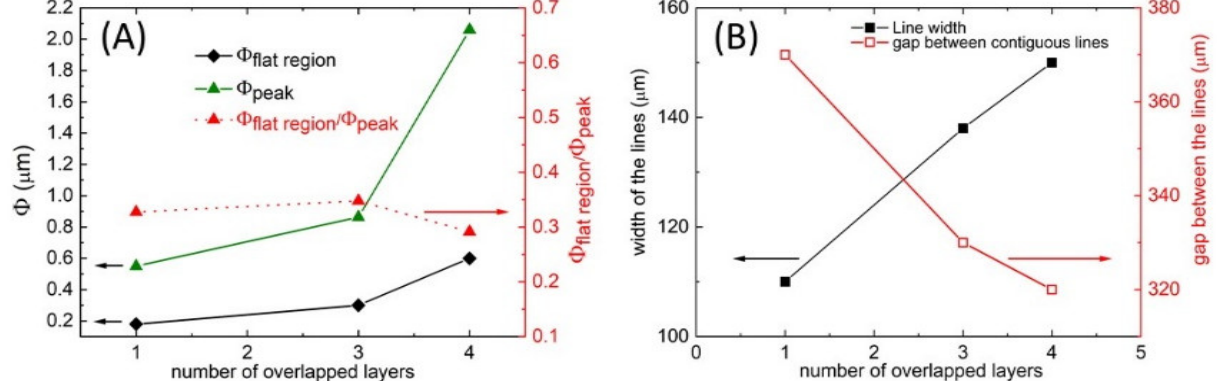
Figure 3. Geometric parameters measured for the PVA lines deposited on PLA substrate (see optical images, displayed in Figure 2). ( A ) Thickness ( Φ ) of the flat region and lateral peaks of the printed line and their ratio. ( B ) Line width and gap between consecutive lines. The arrays are obtained by changing only the number of overlapped printed layers.